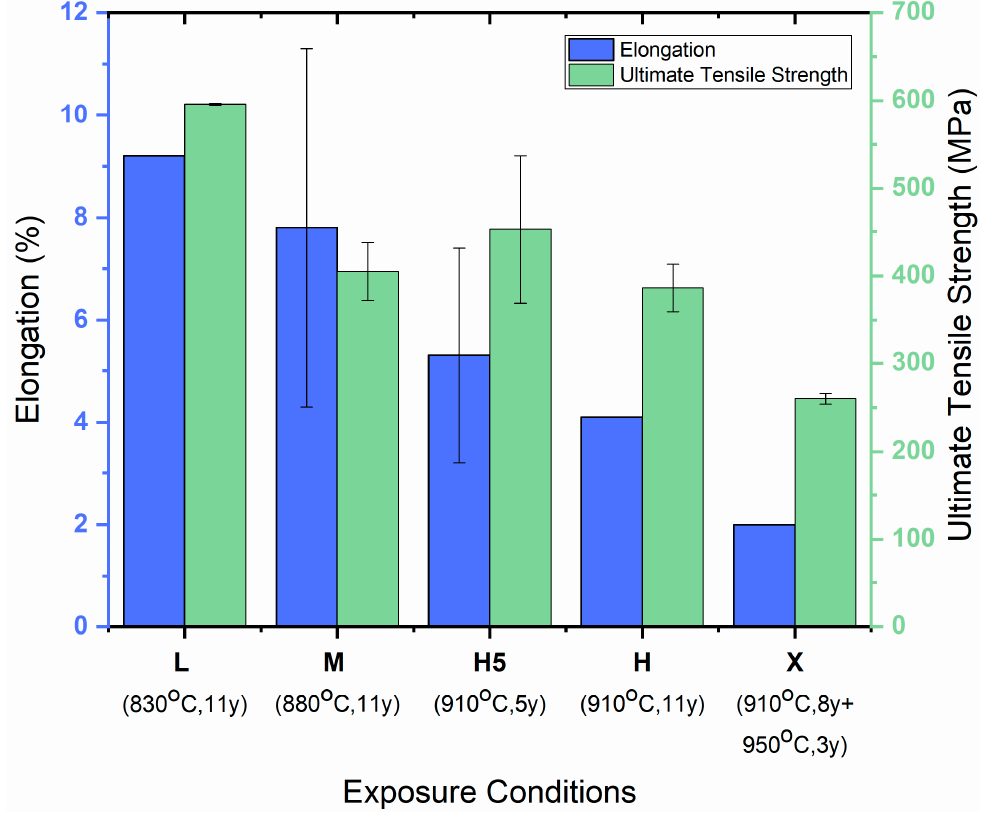
Figure 1. Room-temperature tensile properties vs. creep exposure conditions.